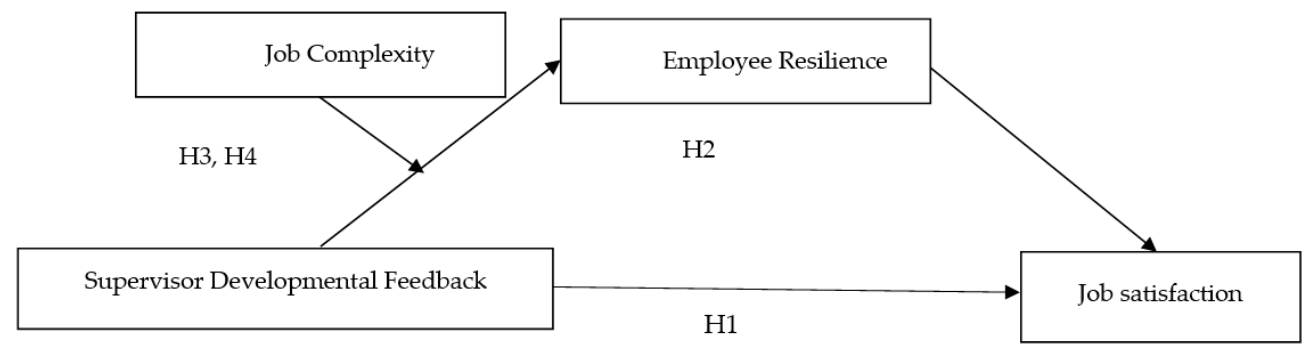
Figure 1. Research model.